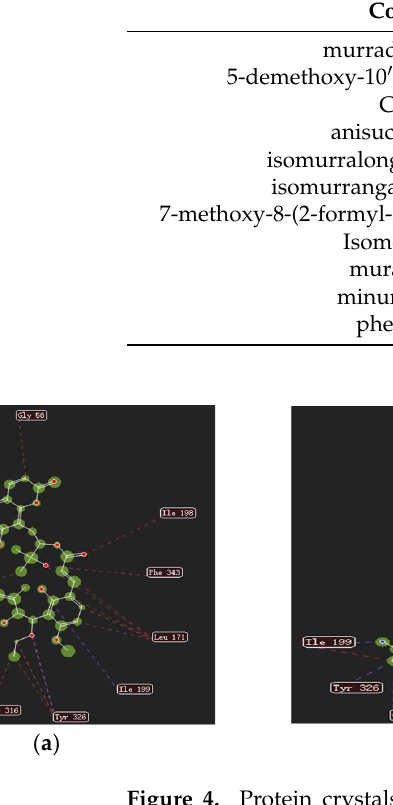
Table 3. Docking scores of coumarins of Murraya exotica L.